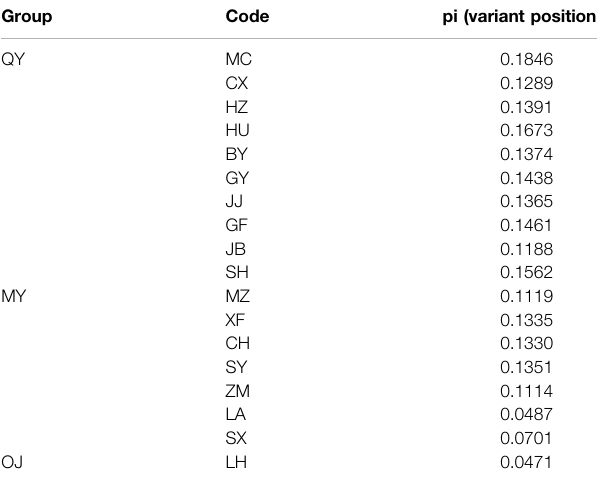
TABLE 2 | The nucleotide diversity (pi) of Odontobutis potamophilus of each population, including variant positions and all positions. Group Code